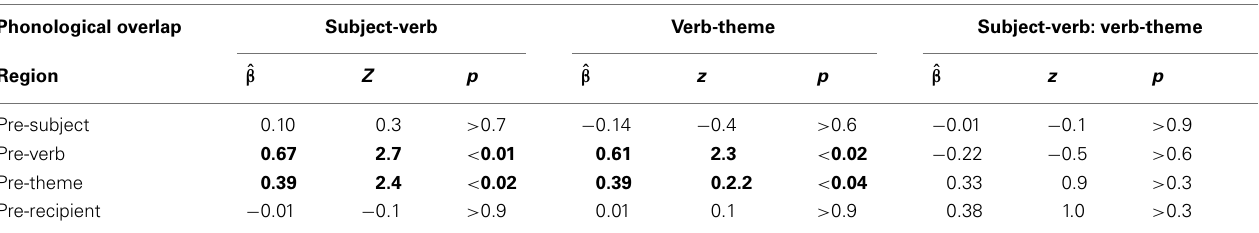
Table 2 | Disfluency results by sentence region.